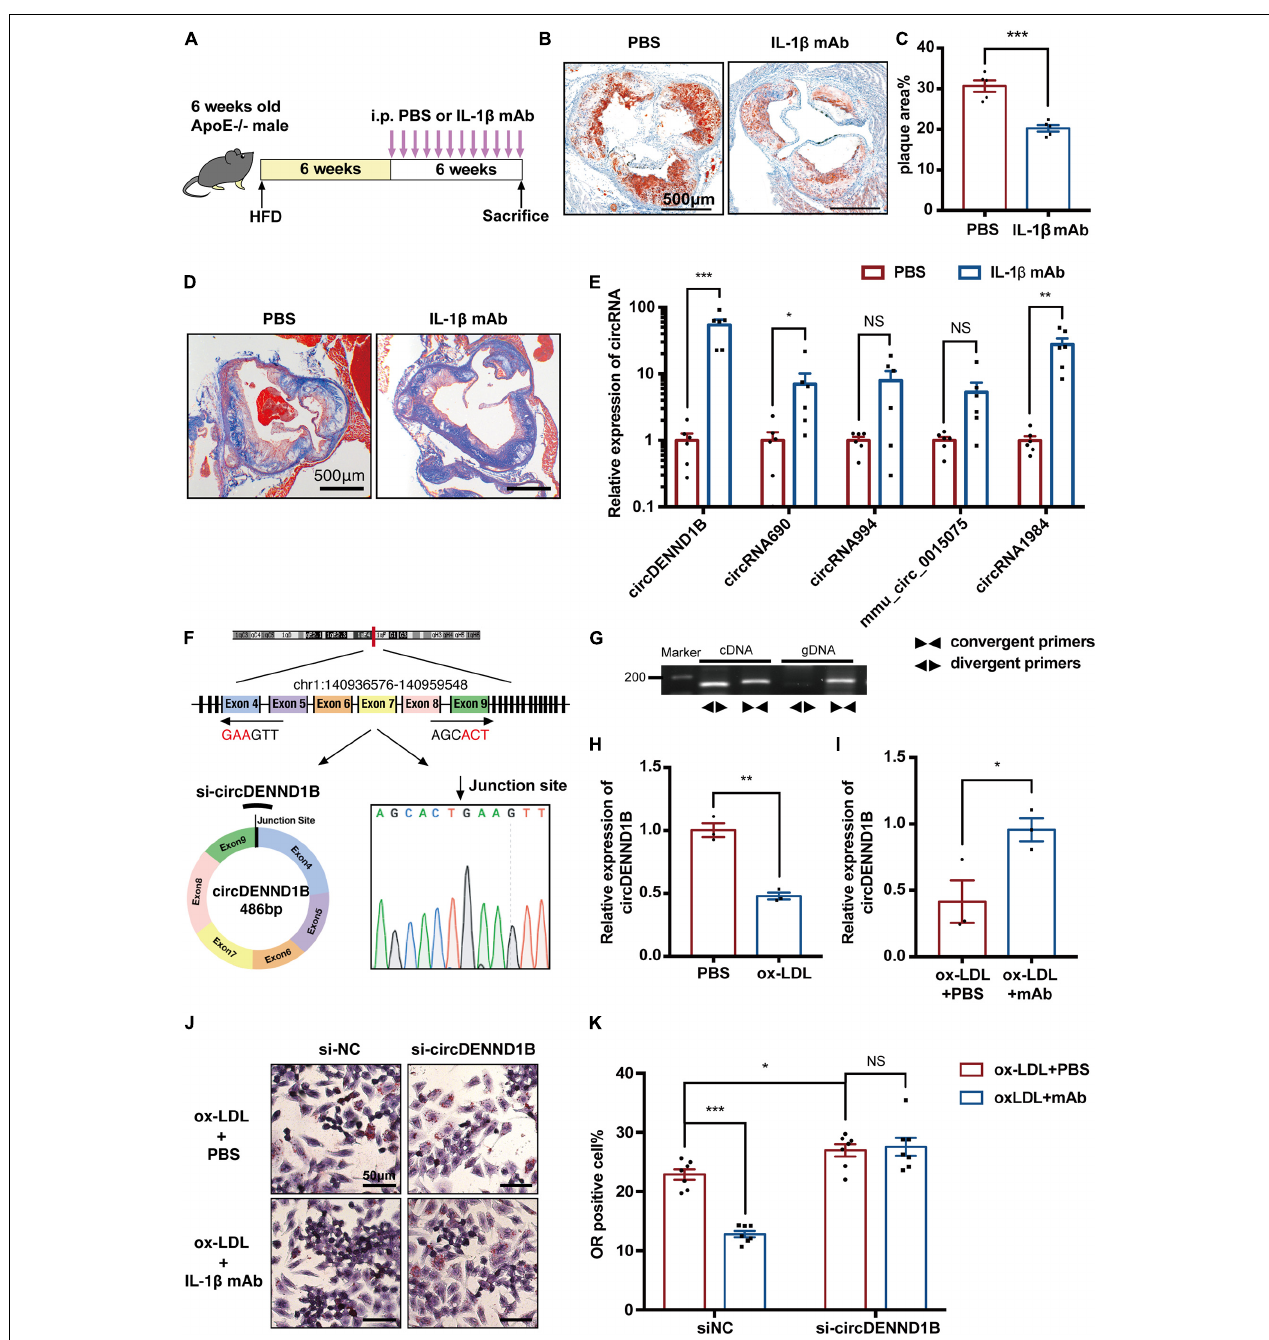
FIGURE 2 | circDENND1B participates in the antiatherosclerotic effect of IL-1 β mAb in vitro , and its expression was affected by IL-1 β mAb in vivo. (A) Schematic depiction of the study in which ApoE - / - mice were fed a HFD for 12 weeks and treated with PBS or IL-1 β mAb. (B) ORO staining showing that IL-1 β mAb injection resulted in a smaller plaque area in the aortic roots. (C) Quantification of the percentage of plaque area compared to the total area of aortic roots ( n = 5 per group). (D) Representative picture of Masson’s trichrome staining of aorta roots. (E) The expression of five circRNAs in aortas was detected with qRT-PCR. Data were normalized to GAPDH ( n = 6 per group). (F,G) Schematic depiction of circDENND1B’s structure, showing it is comprised of the fourth to ninth exon of Dennd1b . Agarose gel electrophoresis showing that circDENND1B is a circular RNA. The circRNA was amplified by divergent primers ( (cid:74)(cid:73) ) from cDNA but not from gDNA. Dennd1b , the host gene of circDENND1B, was amplified by convergent primers ( (cid:73)(cid:74) ) from both cDNA and gDNA. Sanger sequencing validated its splicing junction. (H) qRT-PCR shows that circDENND1B expression decreased in RAW264.7 cells treated with ox-LDL. (I) qRT-PCR shows that circDENND1B expression increased after IL-1 β mAb treatment. (J) Representative image of ORO staining, depicting that fewer foam cells are formed in RAW264.7 cells treated with ox-LDL and IL-1 β mAb. (K) The percentage of foam cells was lower after IL-1 β mAb treatment. Approximately 1000 cells were counted per treatment over seven separate experiments. gDNA, genomic DNA; NS, no significant difference, * p < 0.05, ** p < 0.01, *** p < 0.001.